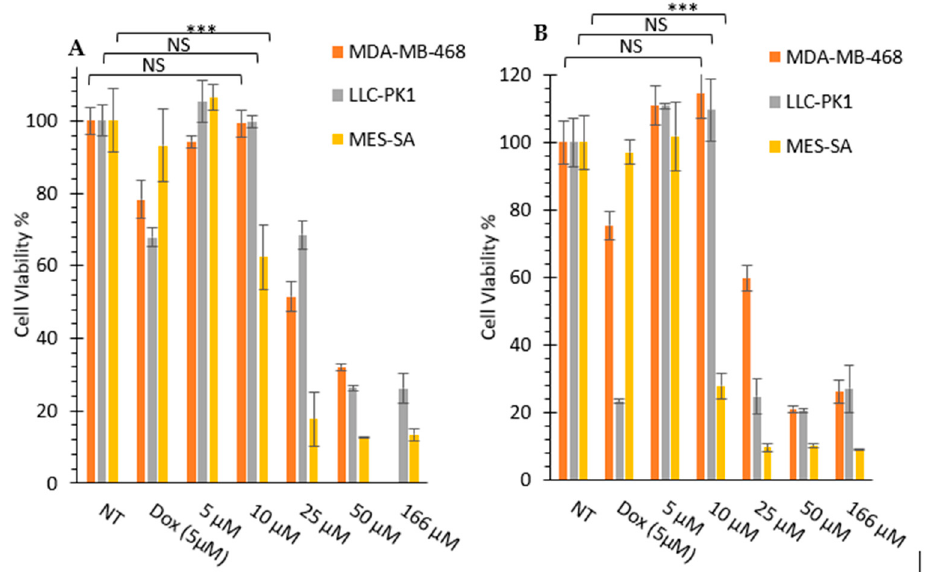
Figure 4. Cytotoxicity study of cyclic ( A ) and linear ( B ) peptides in HEK-293 cells after 24 h incubation (NT = No Treatment) (NS = no significant).